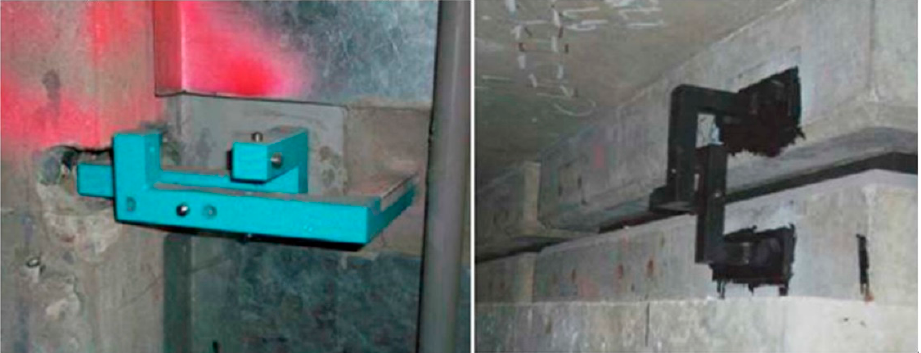
Figure 13. Example of devices used for monitoring the isolation system at the Cruas nuclear power plant [9].